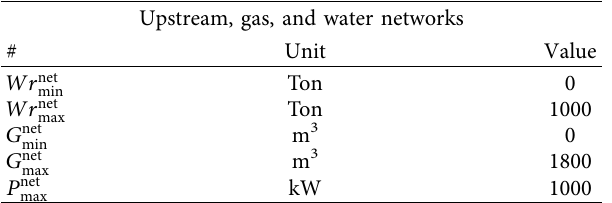
Table 3: Technical parameters of the upstream, gas, and water